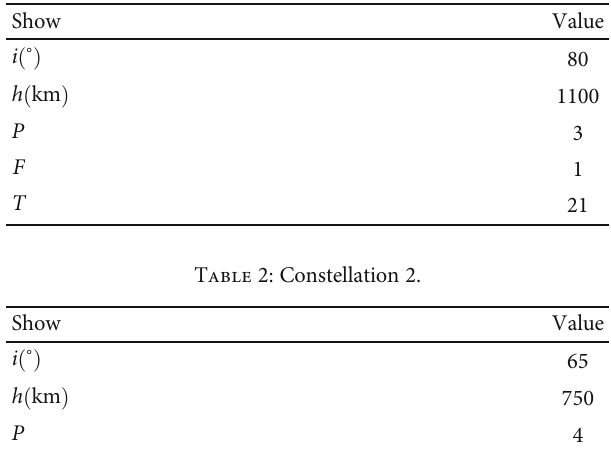
Table 1: Constellation 1.